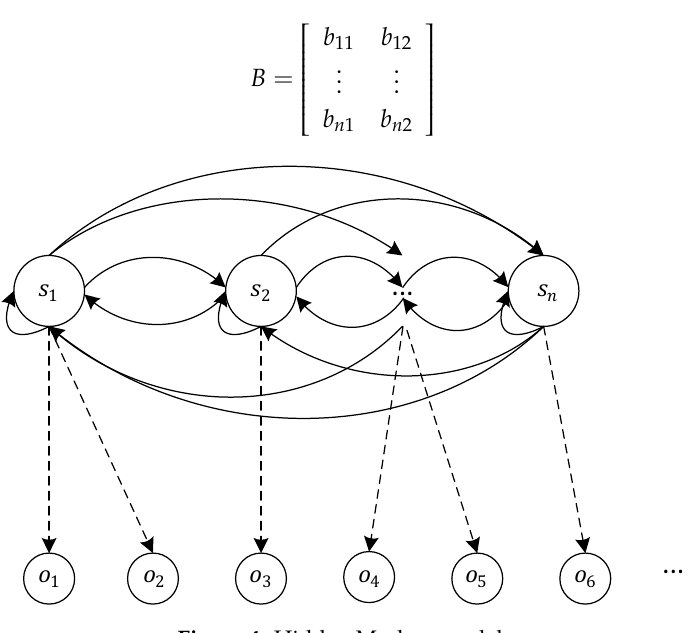
Figure 4. Hidden Markov model.